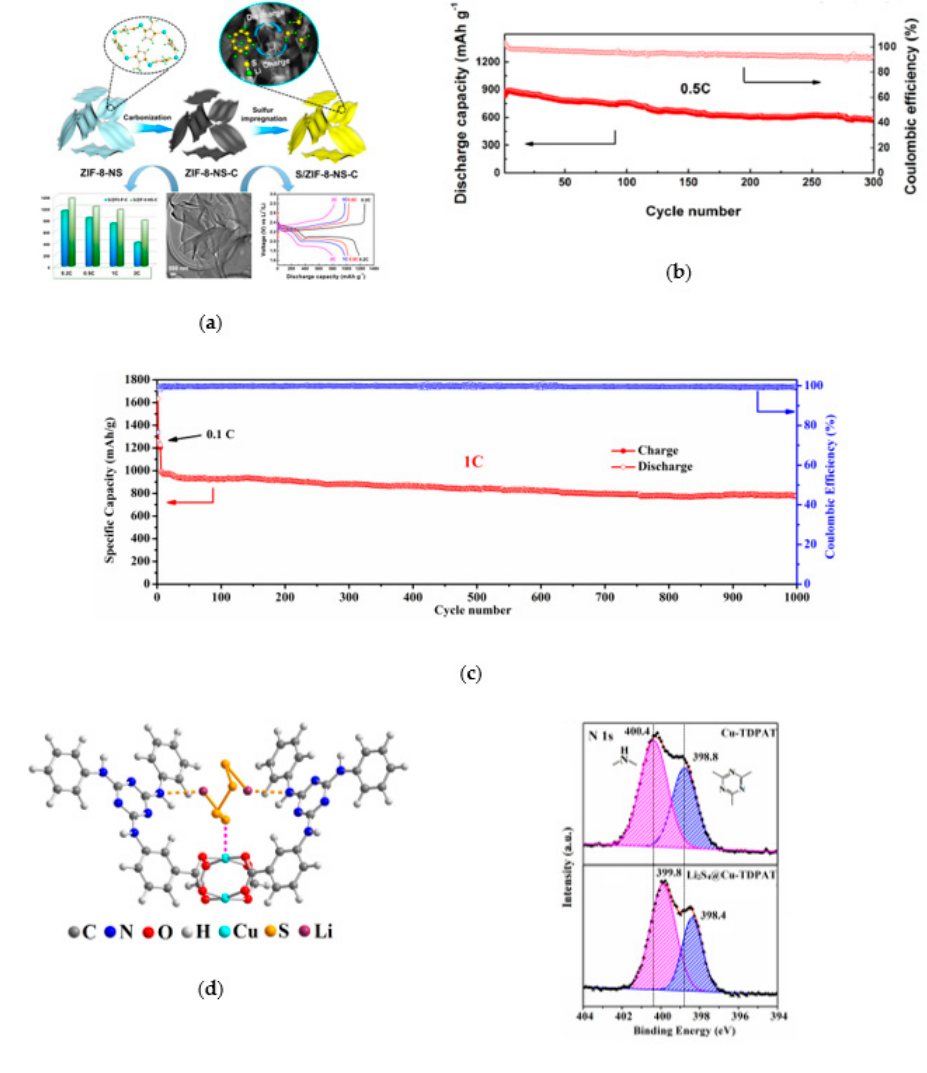
Figure 2. ( a ) Schematic illustration of the S / ZIF-8-NS-C composites preparation [14]. ( b ) Long-term cycling performance of cell S / ZIF-8-NS-C at 0.5 C [14]. ( c ) Cycling stability of S / FMNCN-900 cathode at 2 C for 1000 cycles [15]. ( d ) The optimum atomic model configurations showing the interactions between Cu-TDPAT and Li 2 S 4 [22] . ( e ) XPS N1s spectra of Cu-TDPAT and Li 2 S 4 @Cu-TDPAT